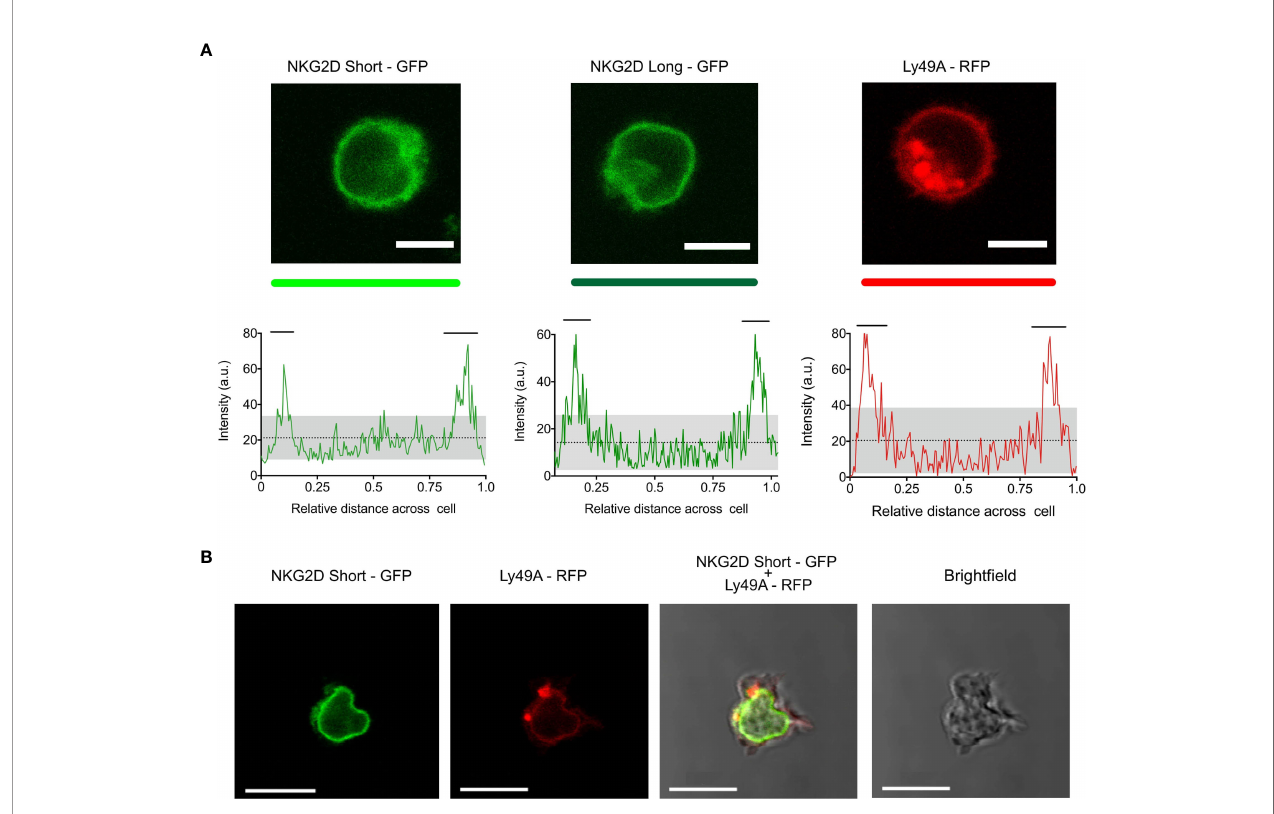
FIGURE 2 | Primary natural killer (NK) cells express NKG2D-GFP and Ly49A-RFP receptors at the cell surface. (A) Confocal z-stack live cell imaging of NKG2D short-GFP, NKG2D long-GFP, and Ly49A-RFP splenic NK cells obtained from retrogenic mice (top). The plot pro fi les show GFP and RFP signal intensities across the cell diameter (bottom). The mean signal intensity is represented by a dotted line. Gray areas represent the lower and upper 95%CI of the mean. Horizontal bars indicate areas of the plot where the signal is above the upper 95%CI of the mean. One representative experiment is shown. Scale bars, 5 um. (B) Confocal z-stack live cell imaging of double-transduced NKG2D short-GFP + Ly49A-RFP NK cell ( in vivo ). Scale bars, 10